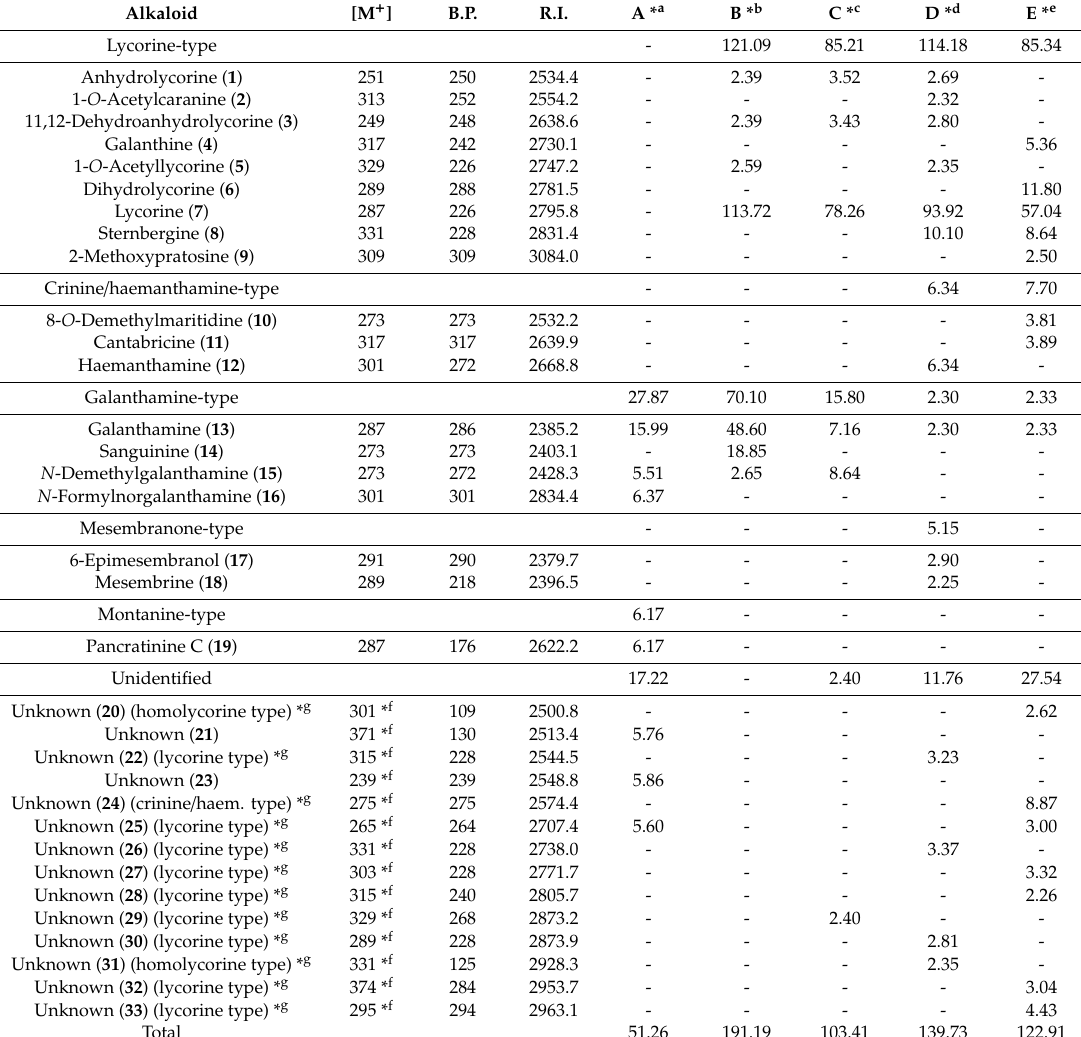
Table 1. Alkaloids identified in di ff erent species of Phaedranassa Herb. from Ecuador by GC-MS. Values are expressed as mg GAL · g − 1